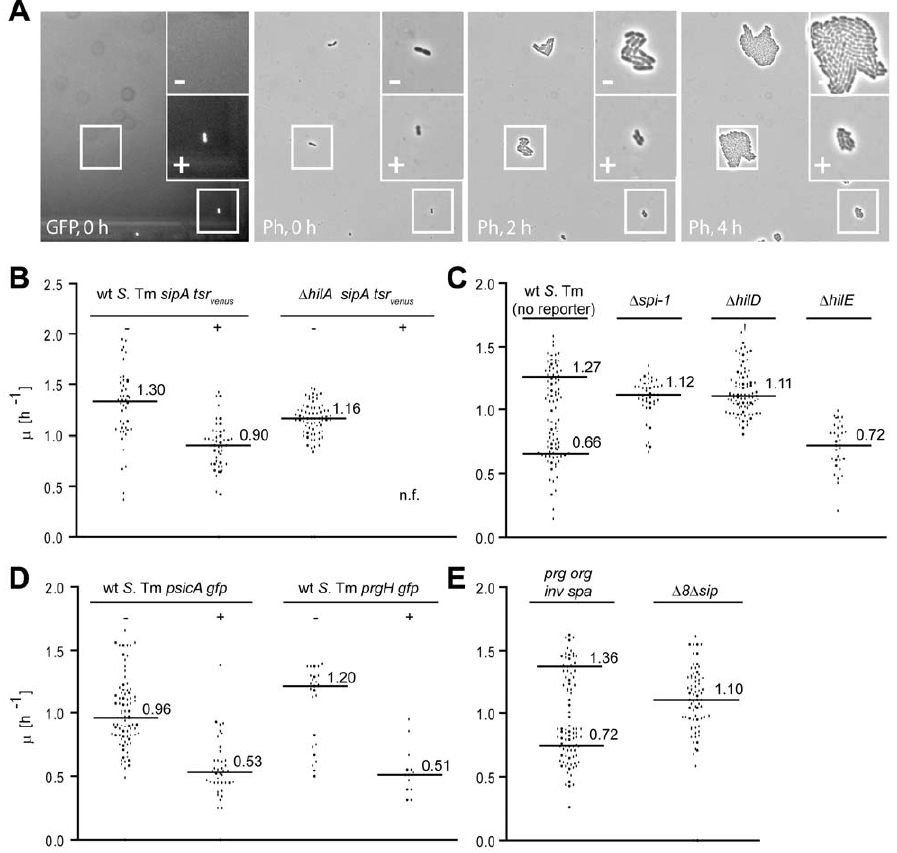
Figure 2. Time-lapse microscopy reveals retarded growth of TTSS-1 + individuals. Bacteria (4 h LB subculture, OD 600 =1), were placed on an agar pad (37 u C) and imaged to detect ttss-1 expression (fluorescence) and growth (phase contrast; 1 frame/30 min). A) Sample images from a typical time-lapse microscopy experiment with wt S . Tm (SL1344, p sicA - gfp ). B)-D): Time-lapse microscopy experiments with wt S . Tm (M2001; sipA - tsr venus ) and an isogenic hilA mutant (M2018; sipA - tsr venus ; B); wt S . Tm (SL1344; no reporter) and mutants lacking ttss-1 , hilD or hilE (no reporter); C); wt S . Tm (SL1344; p sicA - gfp and an isogenic wt reporter strain (SL1344 prgH-gfp ; D); mutants lacking most genes encoding the TTS apparatus ( prg-org, inv-spa ) or most effector proteins and the translocon ( D 8 D sip ); E). Each data point represents the growth rate of an individual micro colony. Data were from $ 3 independent experiments. Black line, median; Numbers, median growth